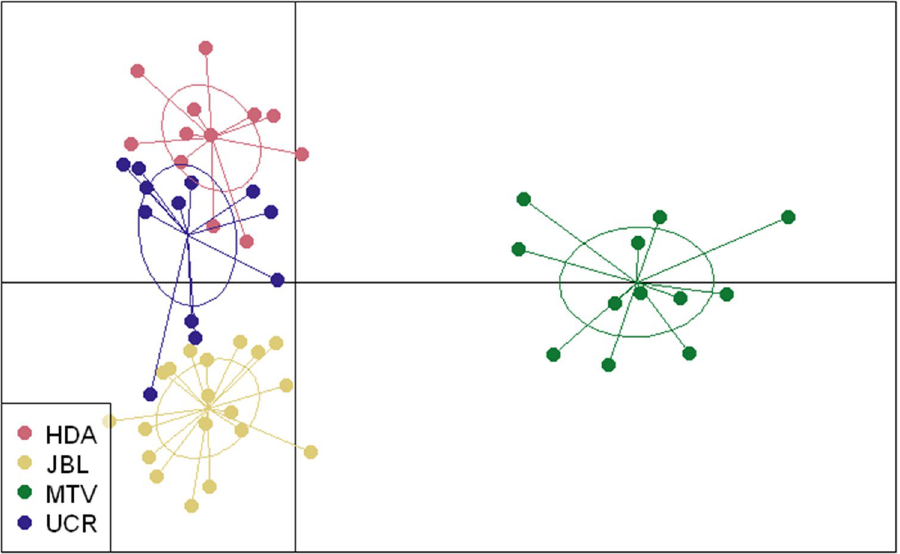
Figure 1. DAPC clustering for individuals of white-eared ground-sparrows ( Melozone leucotis ) for Heredia (HDA), Lankester Botanical Garden (JBL), Monteverde (MTV) and University of Costa Rica (UCR) populations with priors set as sampling sites, retaining 27PC after cross-validation.